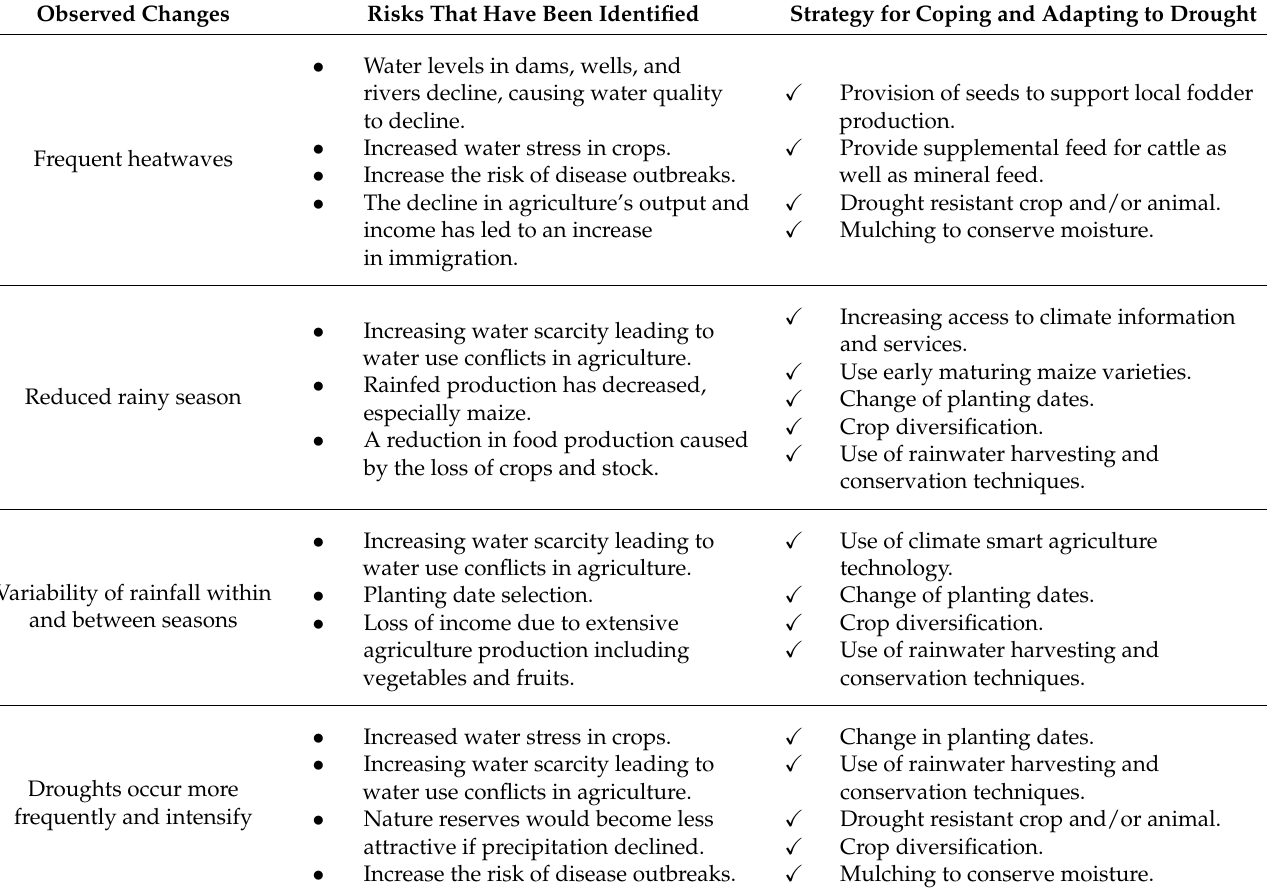
Table 3. Observations of climate change, identifying risks, and adapting